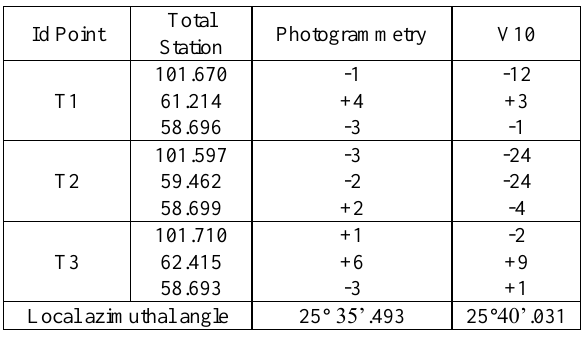
Table 3. Local coordinates expressed in meters and their variation in mm